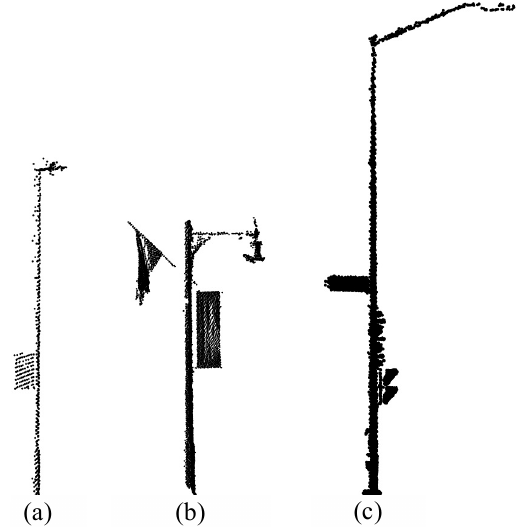
Figure 8 . Templates. ( a ) Template I; ( b ) Template II; ( c ) Template III. Figure 8. Templates. ( a ) Template I; ( b ) Template II; ( c ) Template